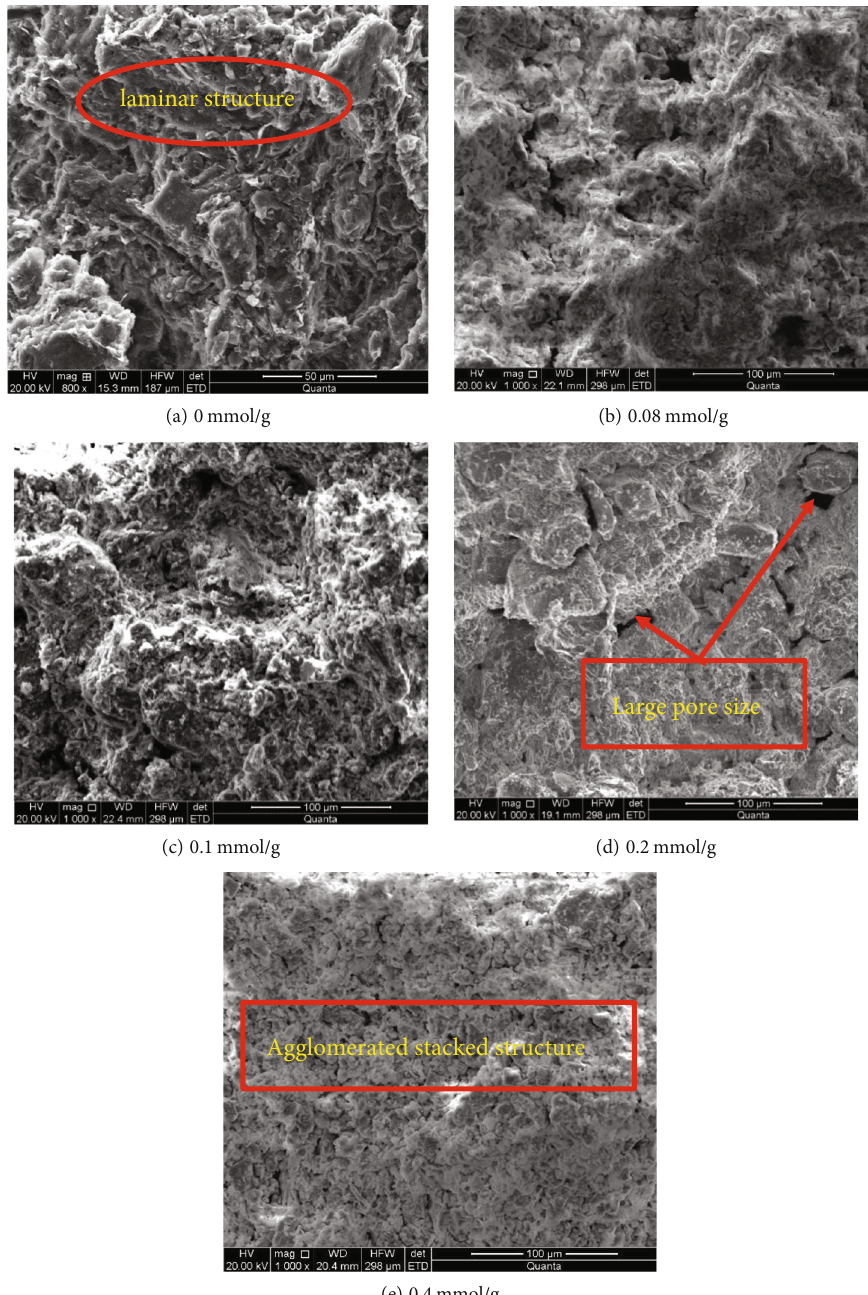
Figure 15: SEM test results of soil samples with di ff erent contents of hydroxyl